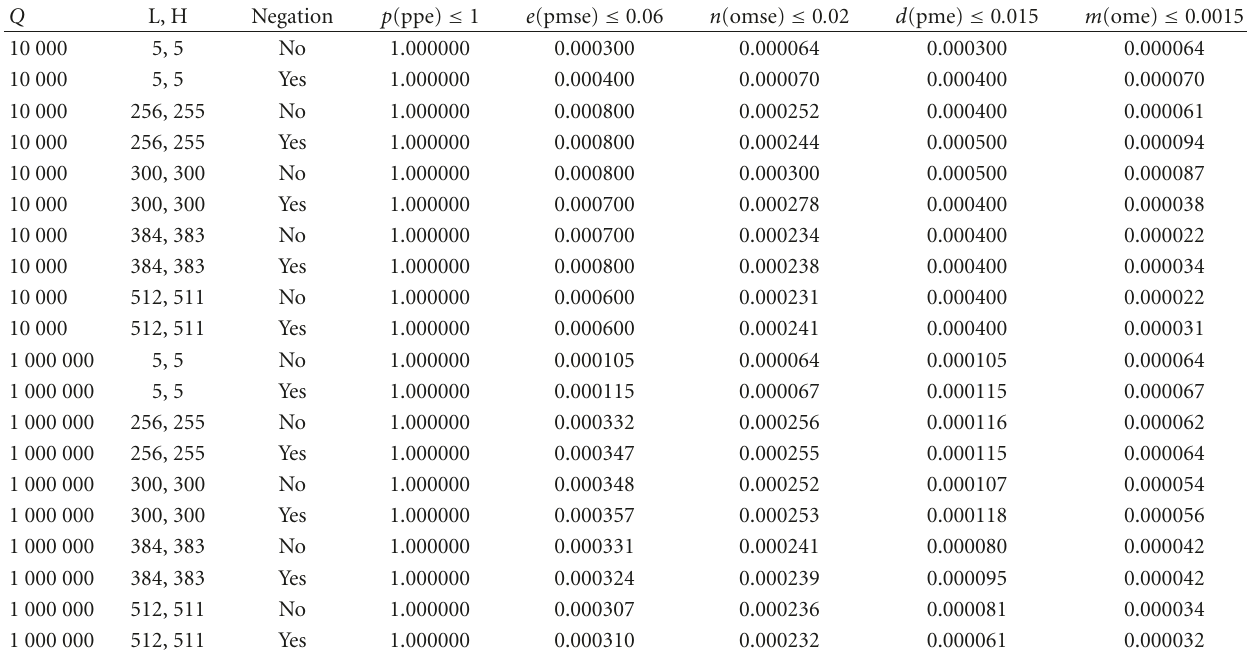
Table 3: IDCT precision performance for 32-bit hardware.